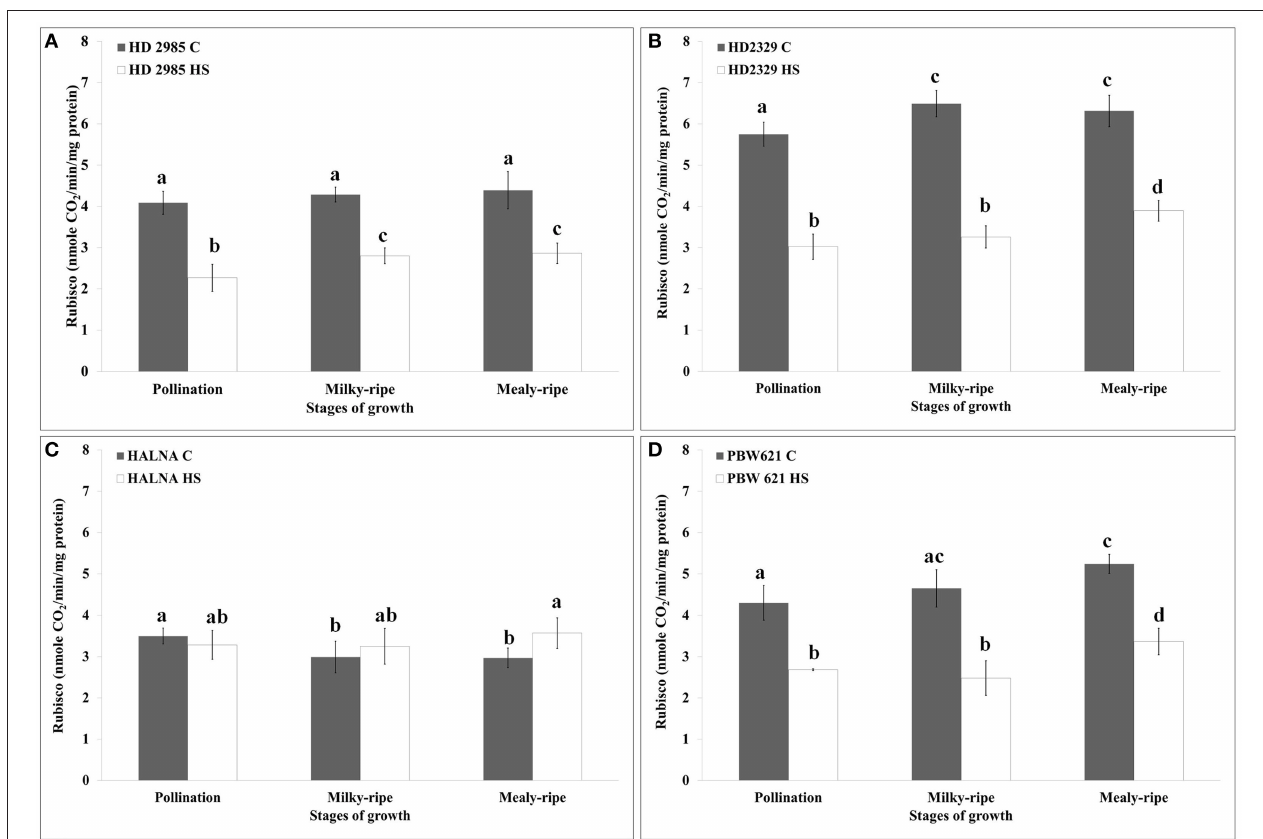
FIGURE 7 | Variations in the RuBisCo activity in contrasting wheat cultivars under control (C) and heat stress (HS) conditions at different stages of growth. (A) HD2985 (C and HS), (B) HD2329 (C and HS), (C) Halna (C and HS), (D) PBW621 (C and HS); samples collected from pollination, milky-ripe and mealy-ripe stages were used for the activity assay; C − 22 ± 3 ◦ , heat stress − 42 ◦ C for 2 h; NaH 14 CO 3 (20mM, specific activity 50 mCi mmol − 1 , BARC, Mumbai) was used for the labeling; different letters above each bar indicate a significant difference ( p < 0.05 ) between the treatments (one-way ANOVA); vertical bars indicate SE ( n = 3